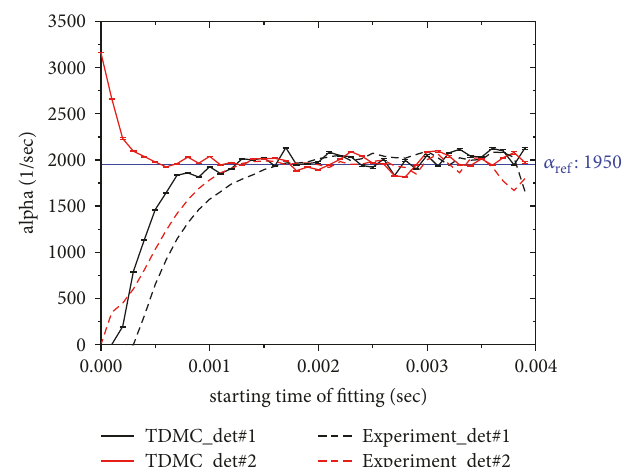
Figure 4: Comparisons of 𝛼 estimates from TDMC and experimental